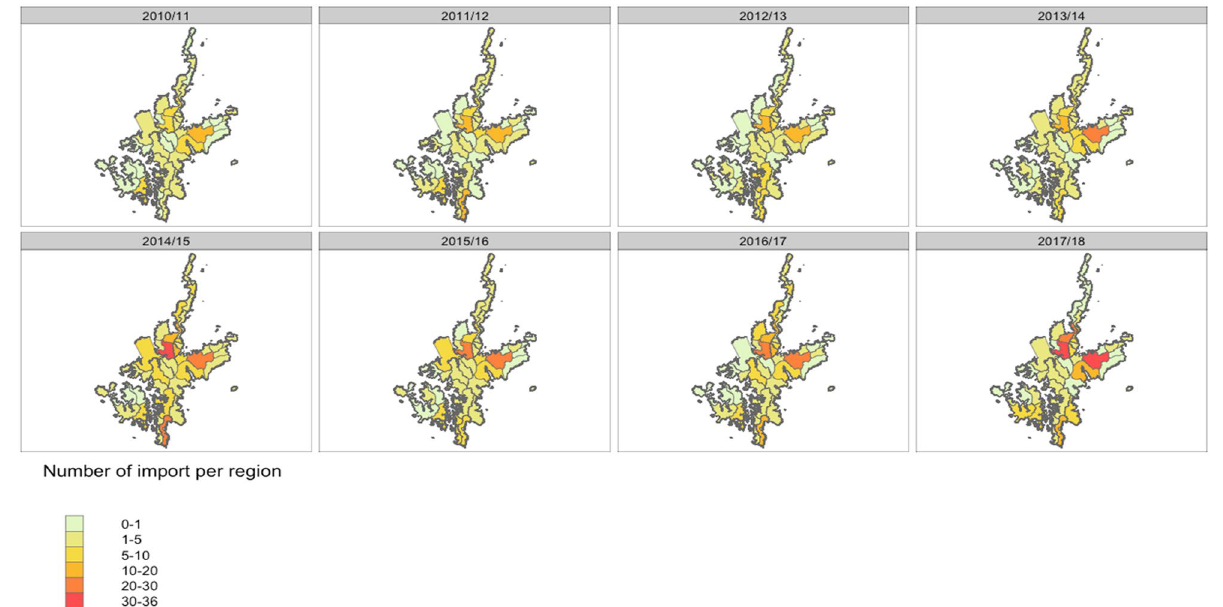
Figure 4. Median number of imported cases stratified by district and by season (2010/11–2017/18).